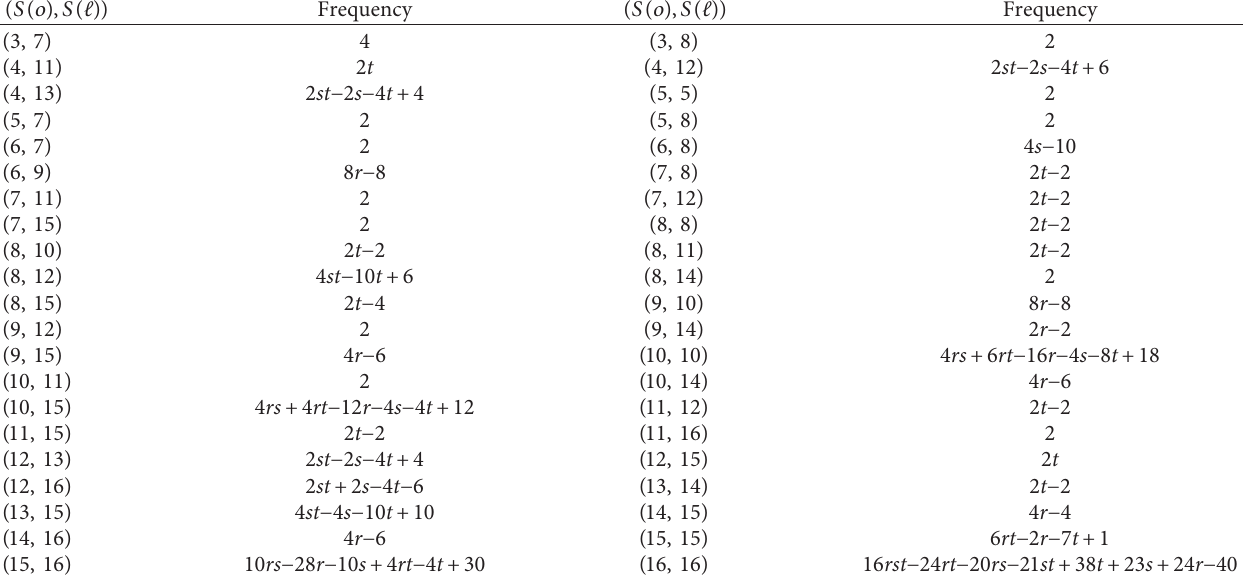
Table 3: Sum degree-based edge partition of M [ r,s, t ] for r, s,t ≥ 3.